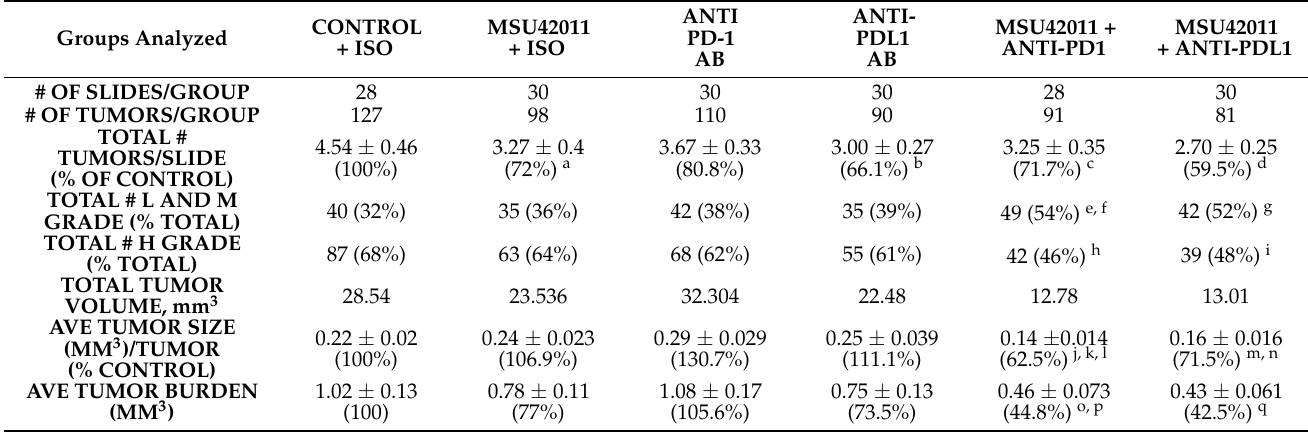
Table 2. The combination of the RXR agonist MSU42011 and anti-PD1 or anti-PDL1 antibodies decreases tumor size and burden in carcinogen-induced model of lung